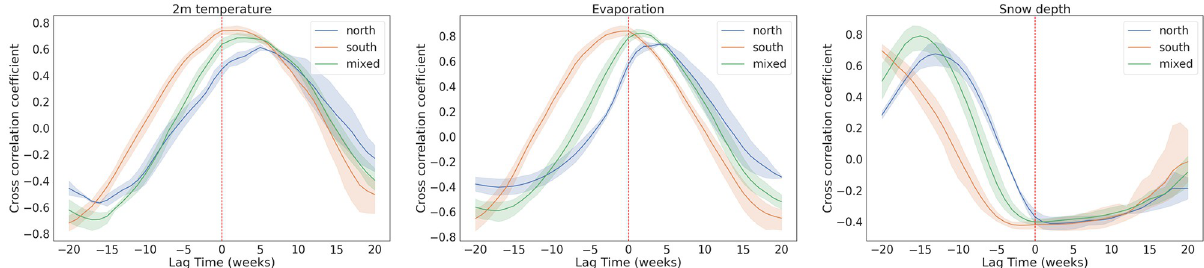
Fig 3. Time lagged cross correlation analysis for the temperature at 2m (left panel), evaporation (middle panel) and snow depth (right panel) variables with respect to the weekly hospital visits due to tick bites. Each panel shows the averaged TLCC curve for the three clusters of federal clusters, according to the tick species inhabiting them, investigated in this